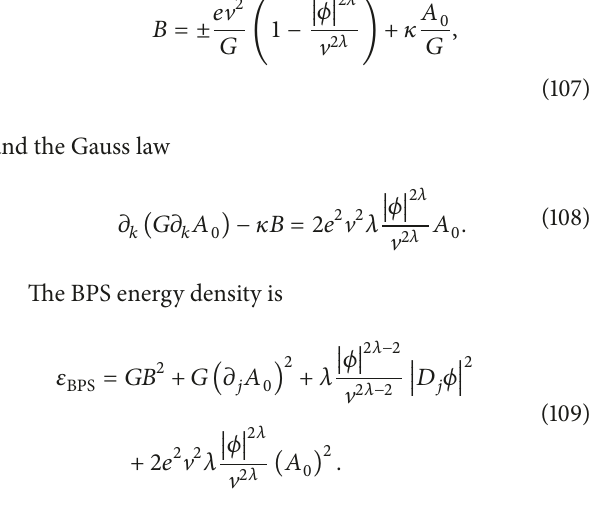
The lower bound (102) is saturated by fields satisfying